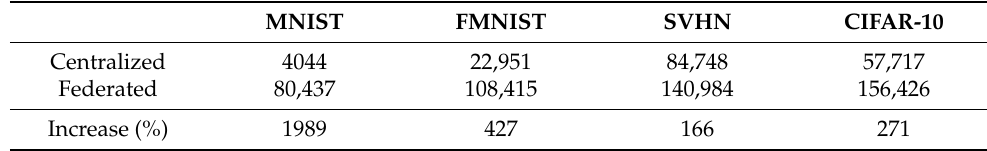
Table 1. Occurrence of example forgetting